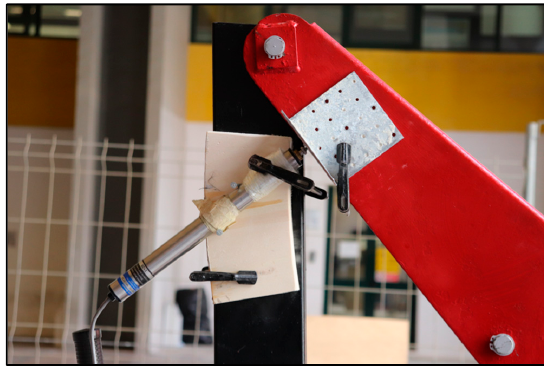
Figure 10. Detail of the Linear Variable Di ff erential Transformer (LVDT)